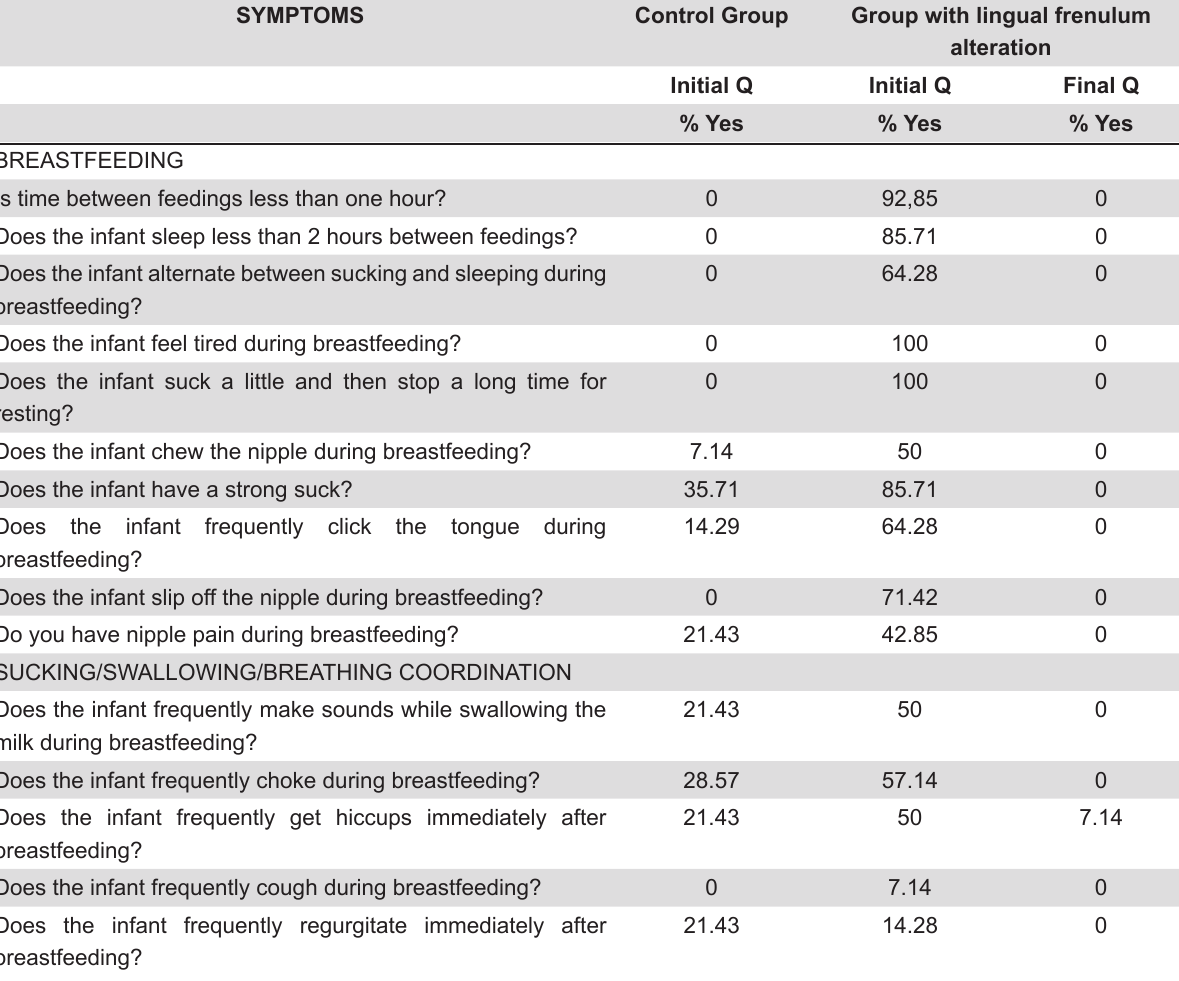
Initial Q=Initial Questionnaire; Final Q=Final